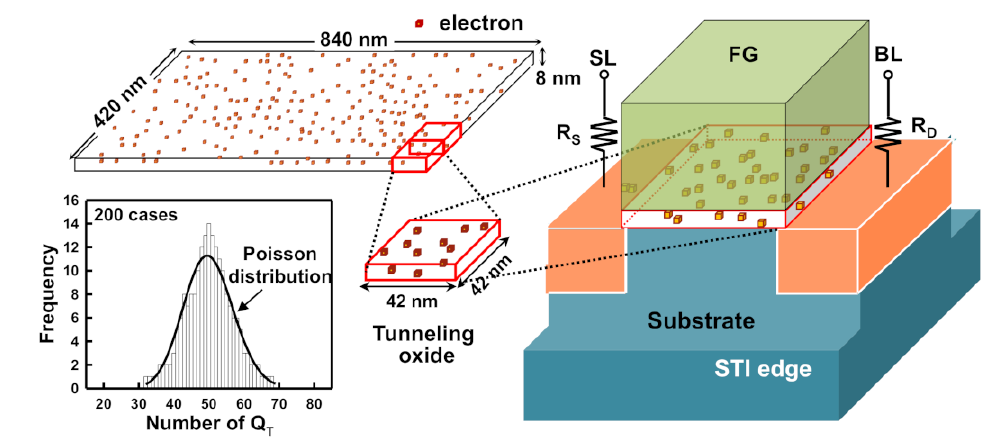
Figure 6. ( a ) Schematic circuit diagram of a NAND string and an equivalent model when cells on WL15 are read. ( b ) Comparison between measured and simulated I D − V CG curve of cells on WL15 at p = 50%, plotted on the linear and logarithmic scales. Adapted from [39].